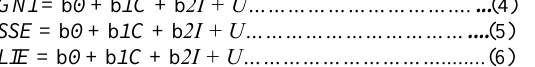
Table 2: Unit Root Test at First